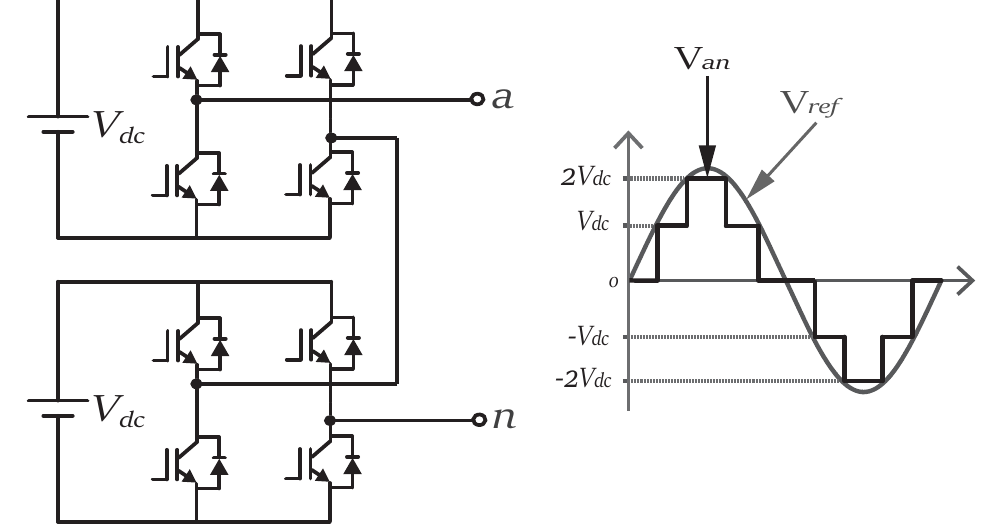
Figure 2. A single-phase leg of a five-level CHB topology and its output voltage